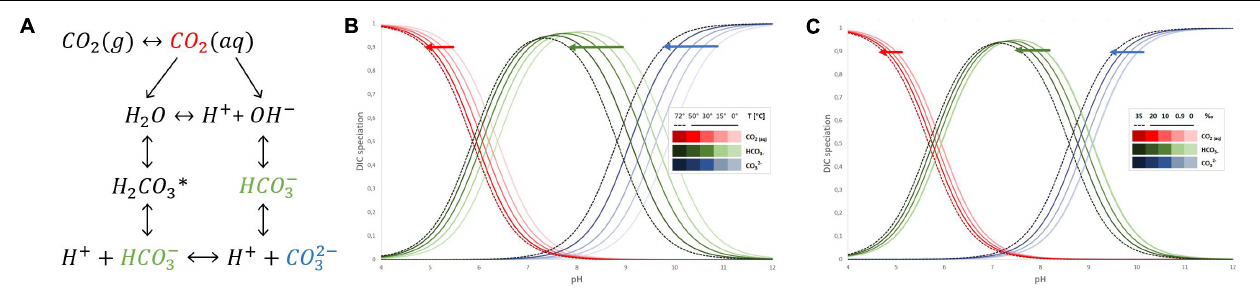
FIGURE 1 | Interconversions of inorganic carbon species in aqueous solution (A) . The effect of temperature on inorganic carbon species distribution across different pH in aqueous solution (B) . The effect of salinity in on inorganic carbon species distribution across different pH in aqueous solution (C) . (cid:104) uptake system encoded by ndhD4 , ndhF4 , and cupB ( chpX )